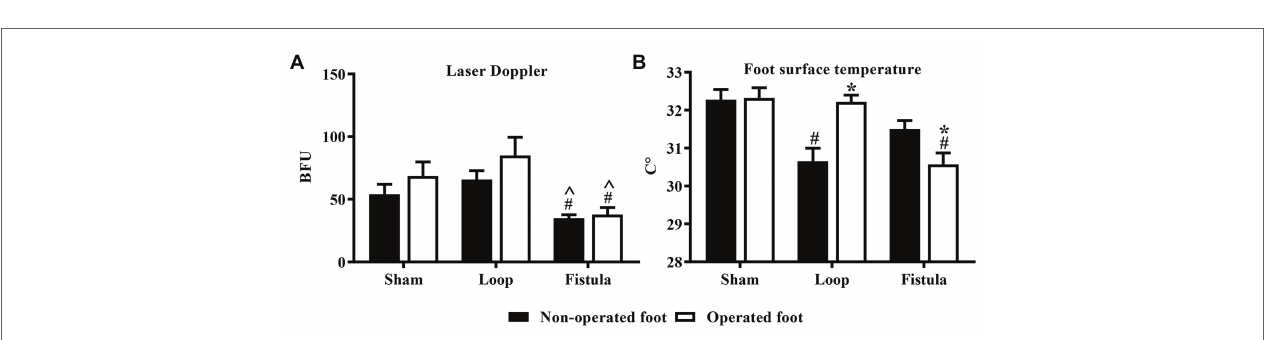
FIGURE 8 | Additional microcirculatory (A) and foot (paw) skin surface measurements on the 5th postoperative week (B) . n = 10, mean ± SEM, ^ p < 0.05 vs. loop group, # p < 0.05 vs. sham-operated group, * p < 0.05 vs. non-operated